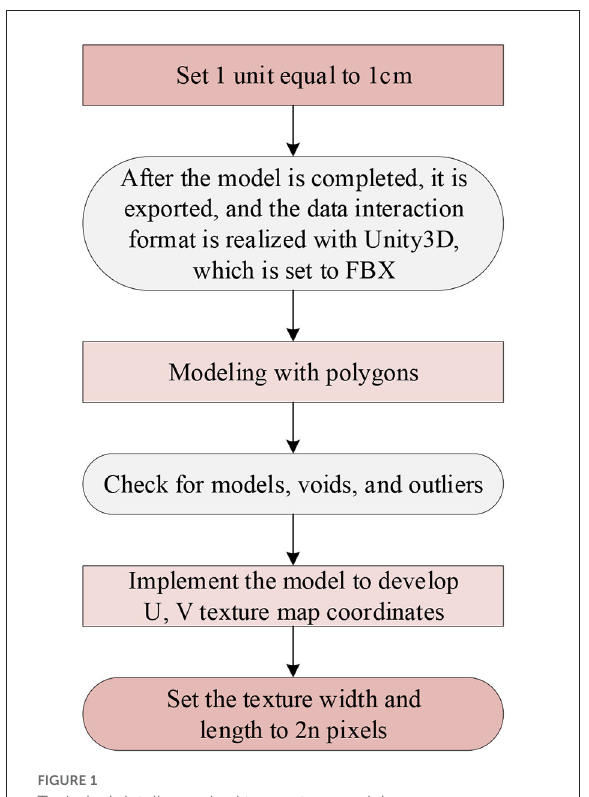
FIGURE1 Technical details required to create a